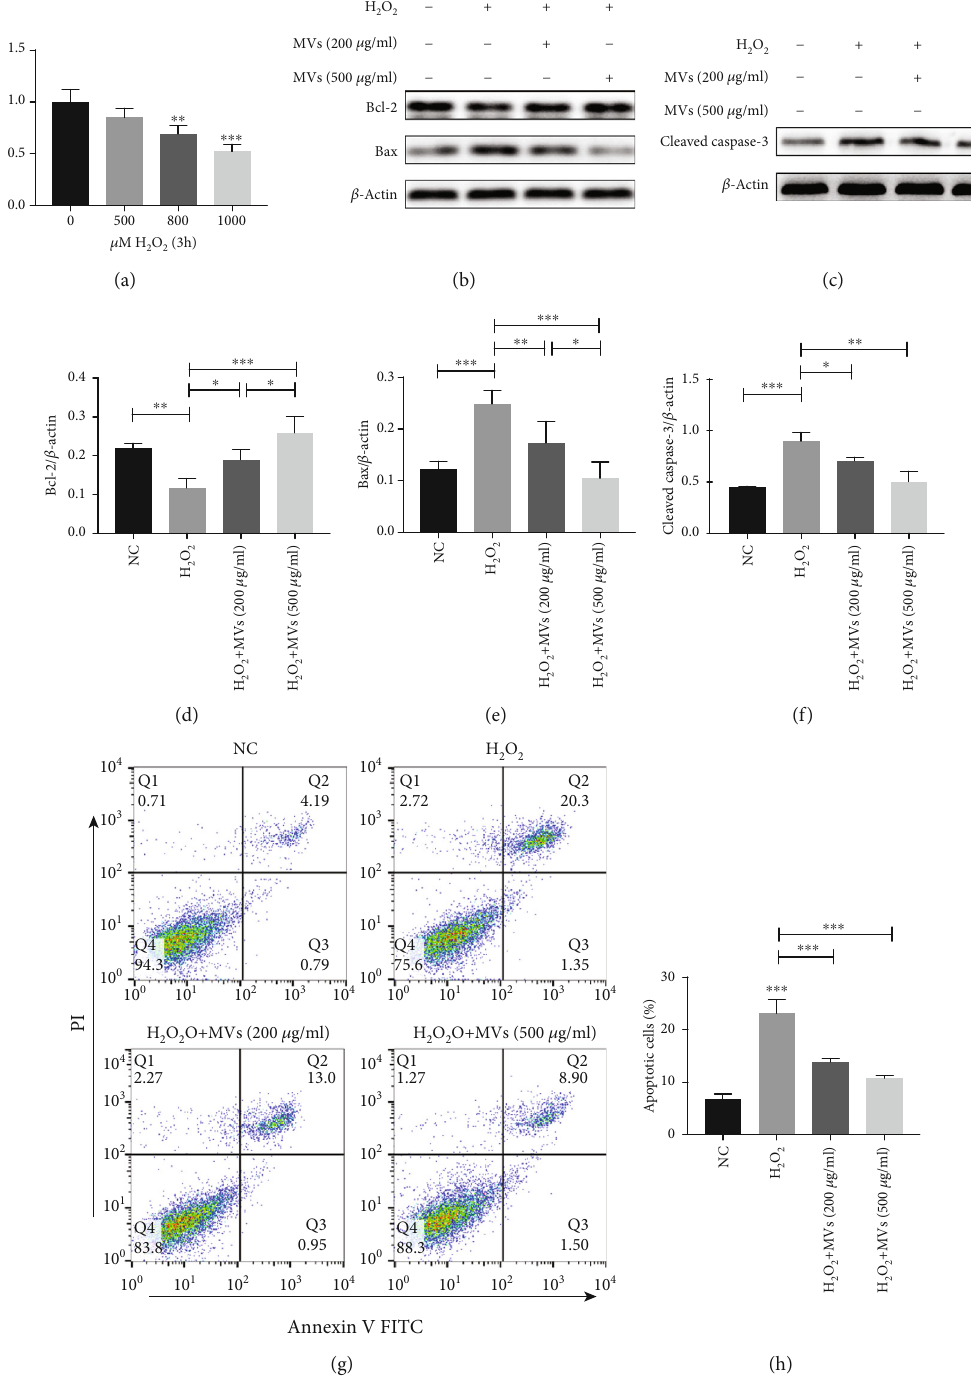
Figure 3: hESC-NSC-derived MVs reduced cell apoptosis after H O stimulation. CCK-8 was used to measure HL-1 cell viability after 2 2 exposure to 0, 500, 800, and 1000 μ M H O for 3h (a). Representative western blot images showing the protein levels of Bcl-2, Bax, and 2 2 cleaved caspase-3. β -Actin was used as an internal control (b – f). Representative dot plots of cell apoptosis were showed after Annexin V/PI dual staining (g). The percentage of apoptotic cells was represent for both early and late apoptotic cells (h). Every experiment was repeated at least three times; error bars indicate mean ± SD ( ∗ P < 0 : 05 ; ∗∗ P < 0 : 01 ; ∗∗∗ P < 0 : 001